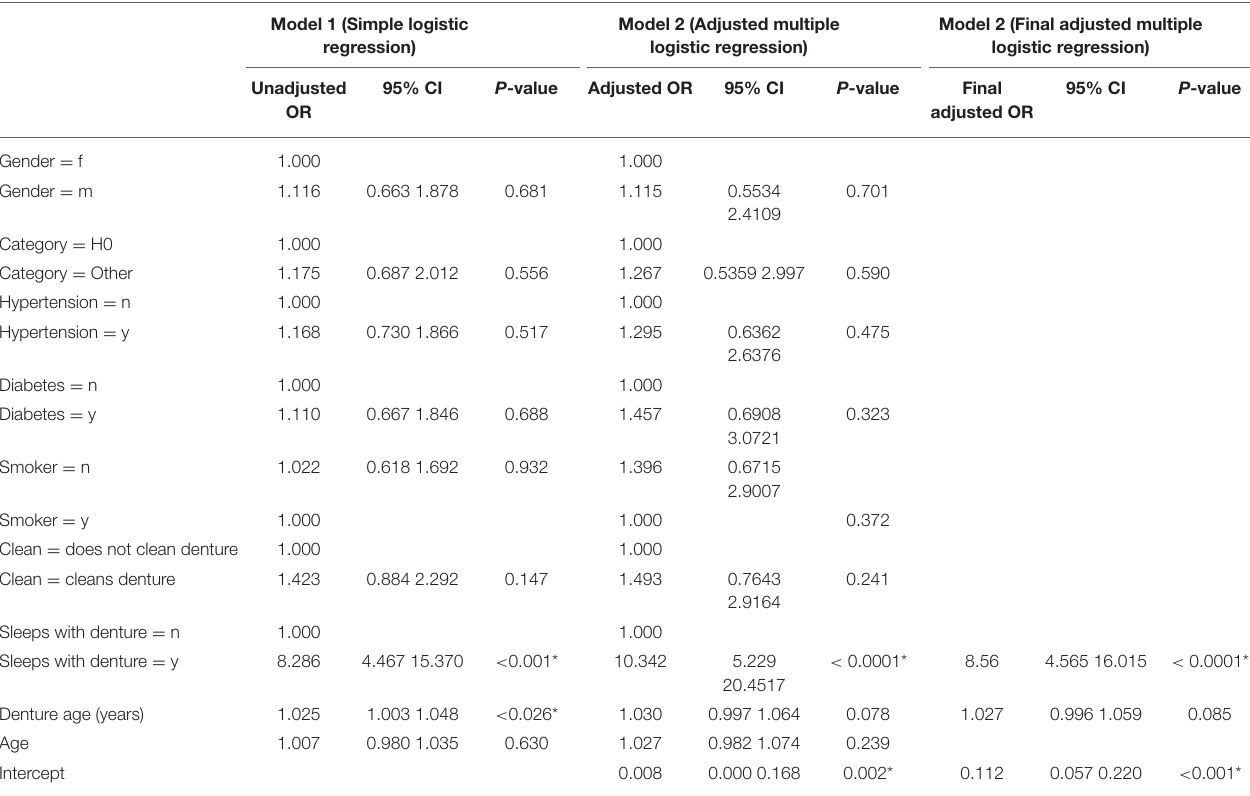
TABLE 2 | Logistic regression -Denture related stomatitis.